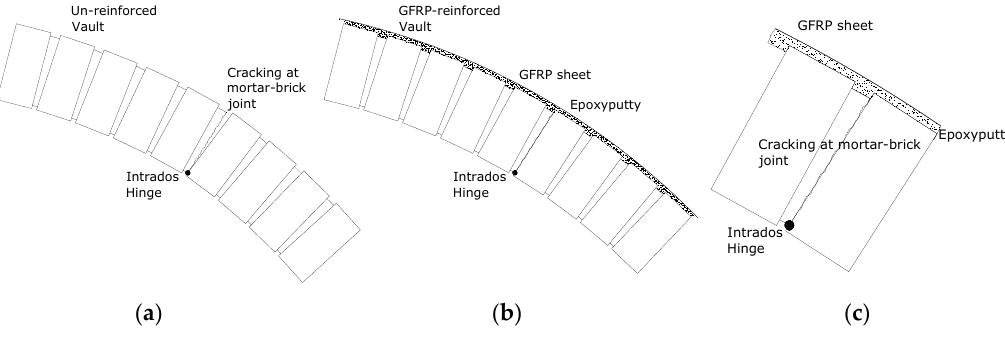
Figure 12. ( a ) Hinge opening at intrados for the un-reinforced vault; ( b ) GFRP reinforced vault; ( c ) detail at the hinge after the application of the reinforcement.